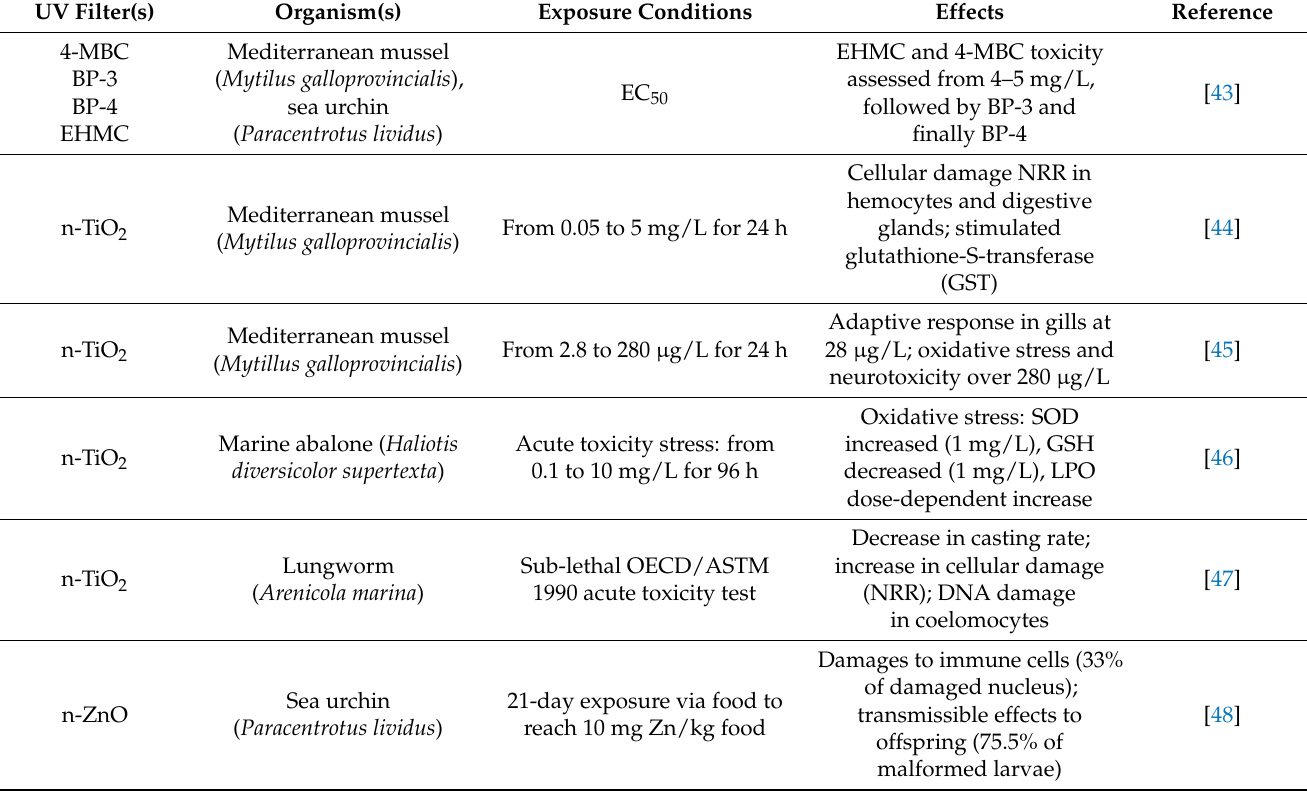
Table 1. Effects of various UV filters from different